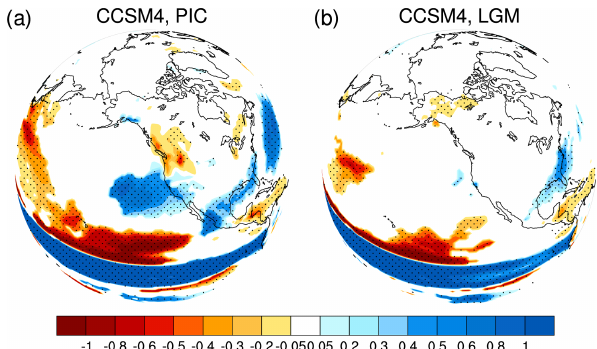
Figure 10. Precipitation regressions on the Nino3.4 index in the CCSM4 PMIP3 simulations. (a) PIC and (b) LGM. Dotted areas indicate significant regressions for the 95% confidence level for 30- year